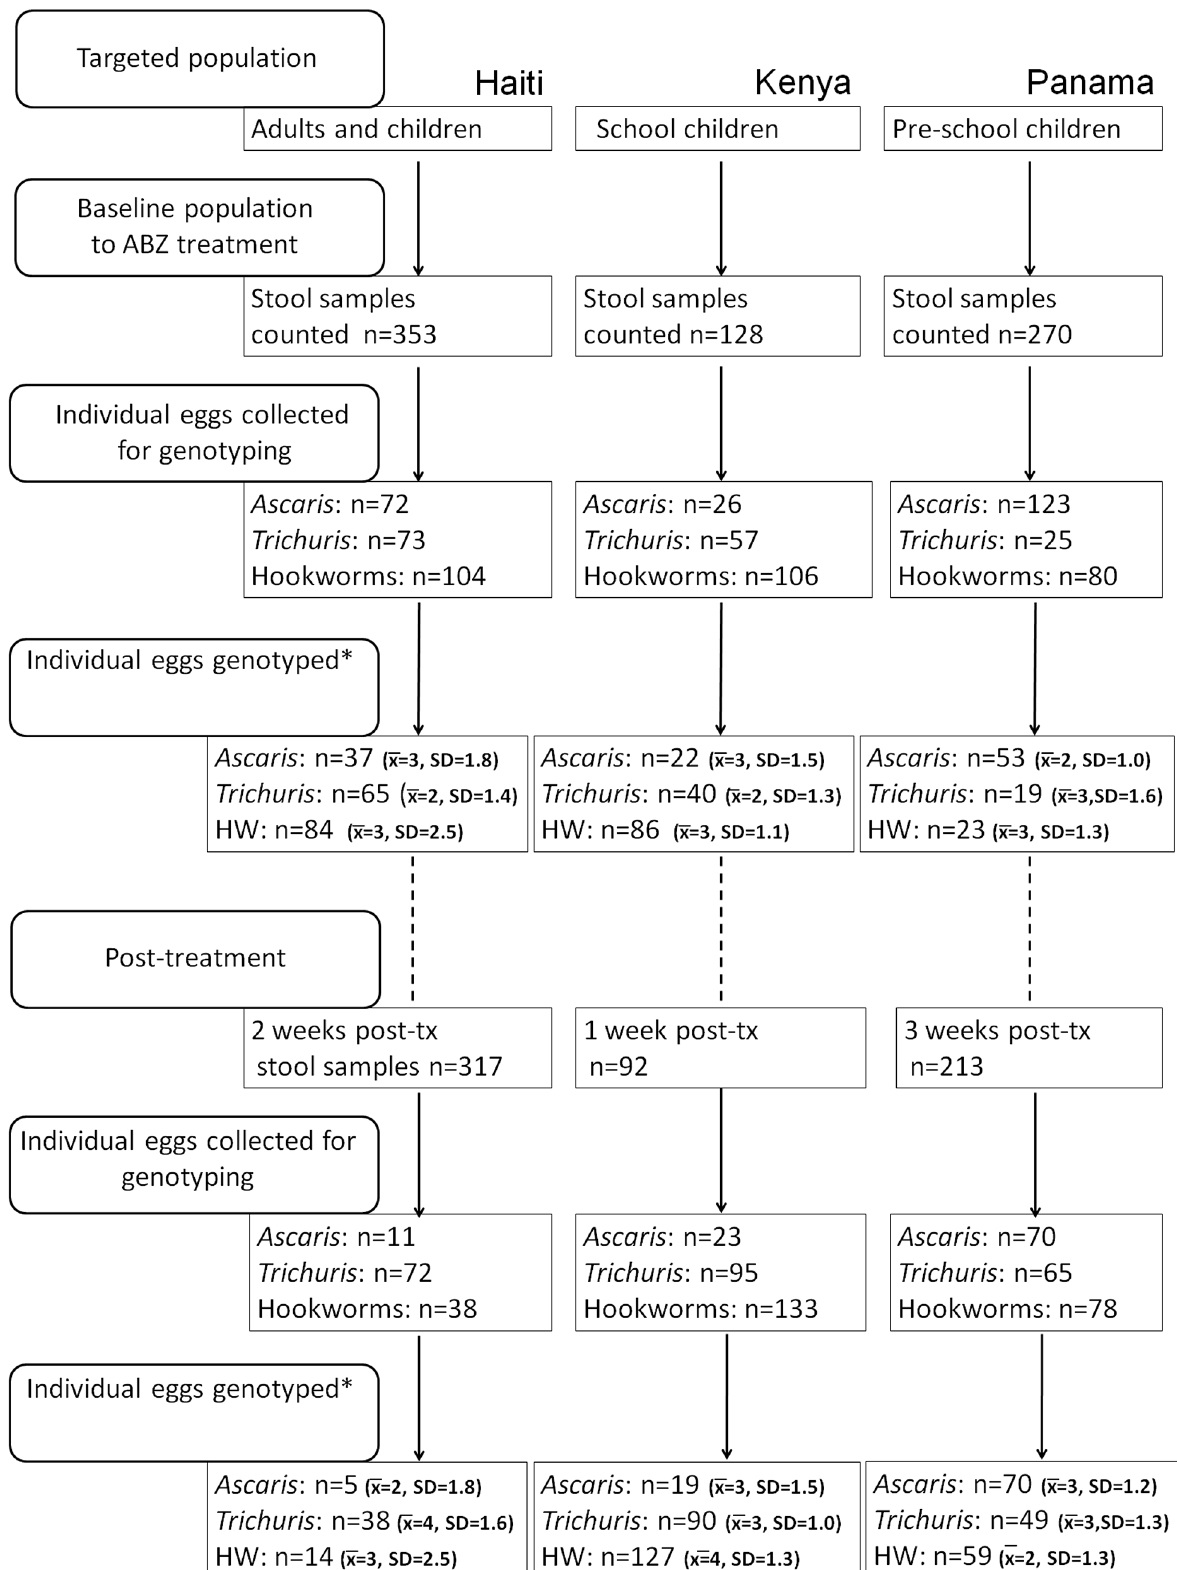
Figure 1. Flow chart of the study designs in Haiti, Kenya and Panama. *The number of eggs genotyped is different from the number of eggs collected. This is due to failures in DNA extraction, PCR amplification or Pyrosequencing. x¯ represents the mean number of eggs sampled per host; SD=standard deviation. The dashed lines mean that the connection between the two boxes is not direct. doi:10.1371/journal.pntd.0002247.g001 PLOS Neglected Tropical Diseases |